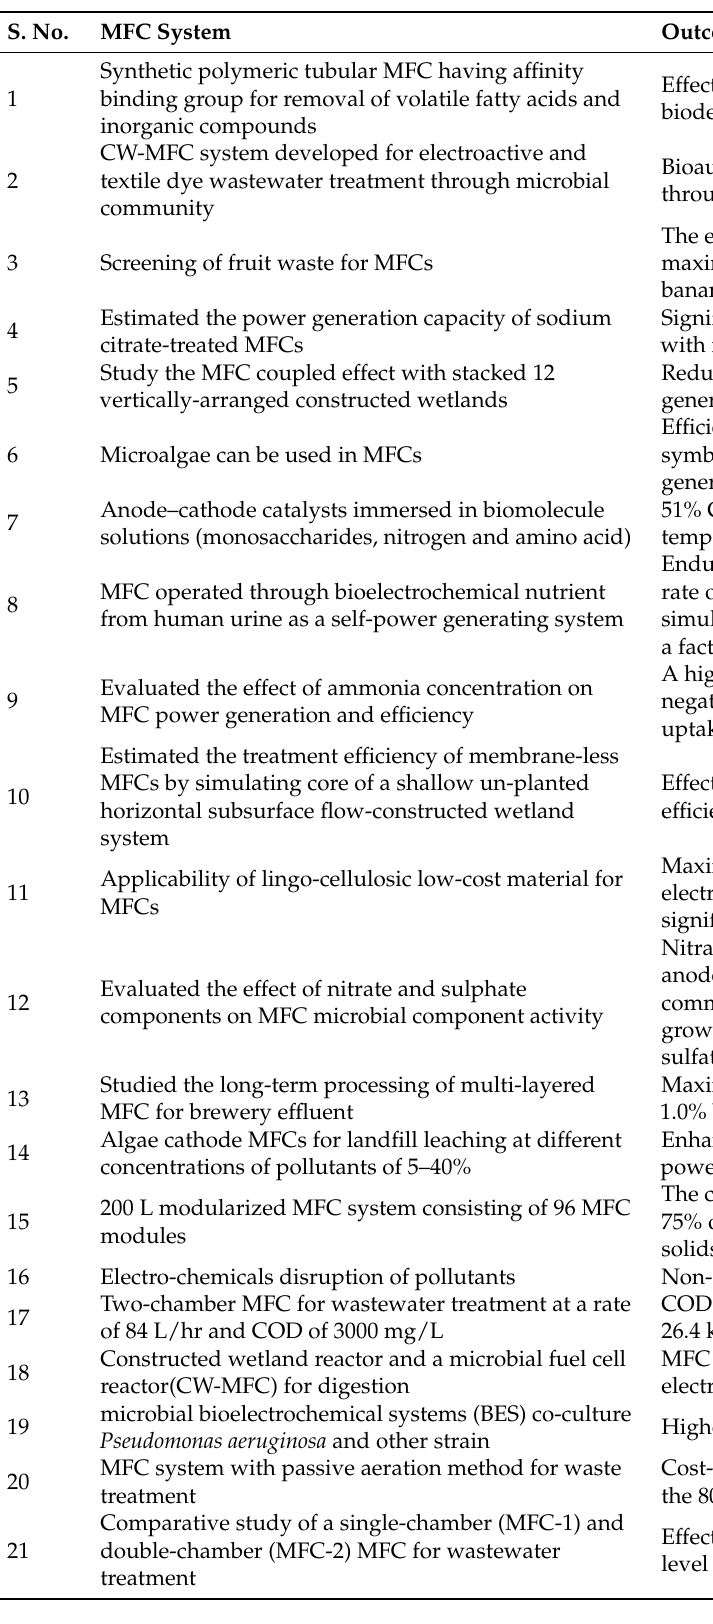
Table 3. Innovative approaches to improve MFC systems and